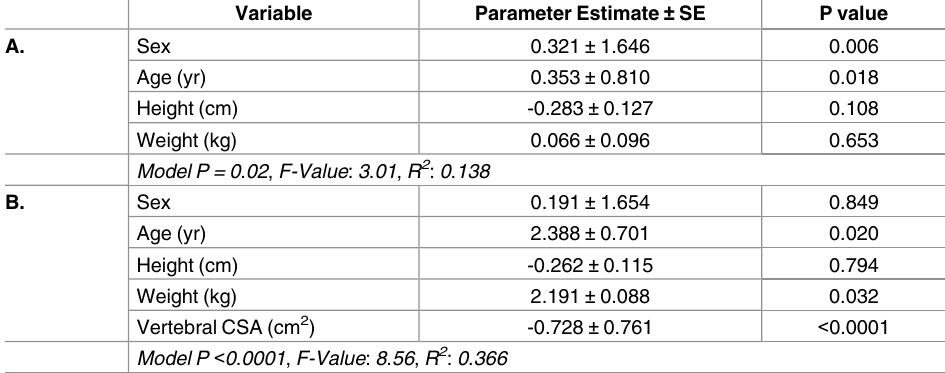
Table 3. Multivariate regression models for the prediction of lumbar lordosis without (A) and with (B) the inclusion of vertebral